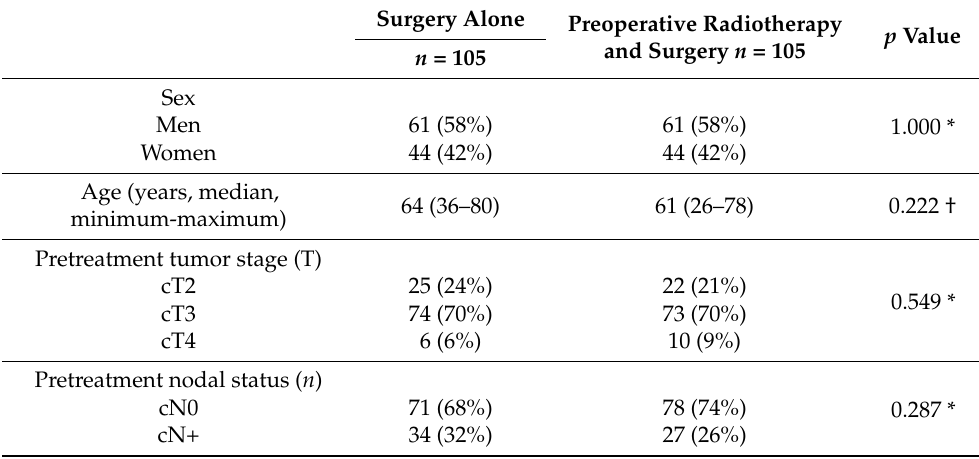
Table 2. Patient clinical and demographic characteristics, by treatment group after propensity- score